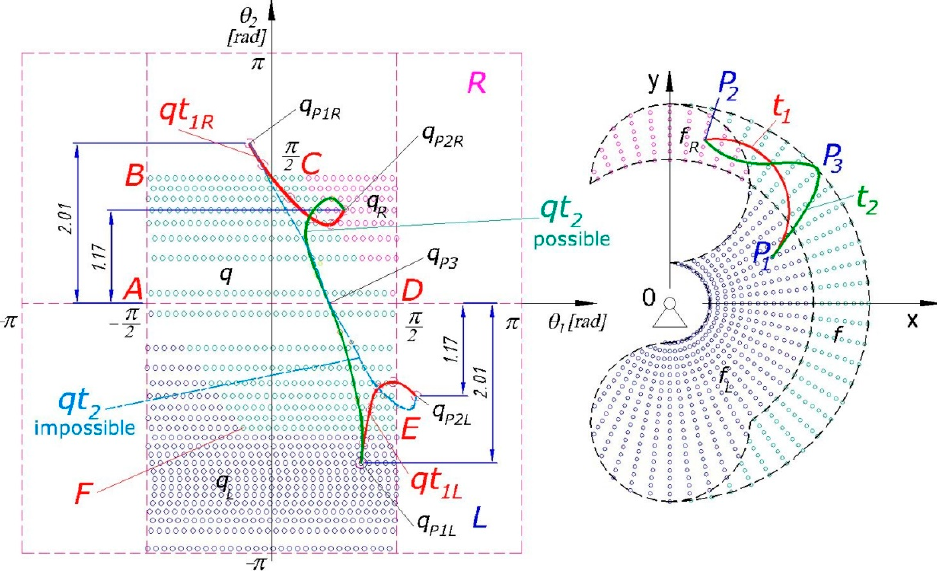
Figure 13. Solutions of the inverse kinematics problem and determination of zones with the proposed algorithm for a two-link mechanism from Figure 11. Transformation of trajectories.